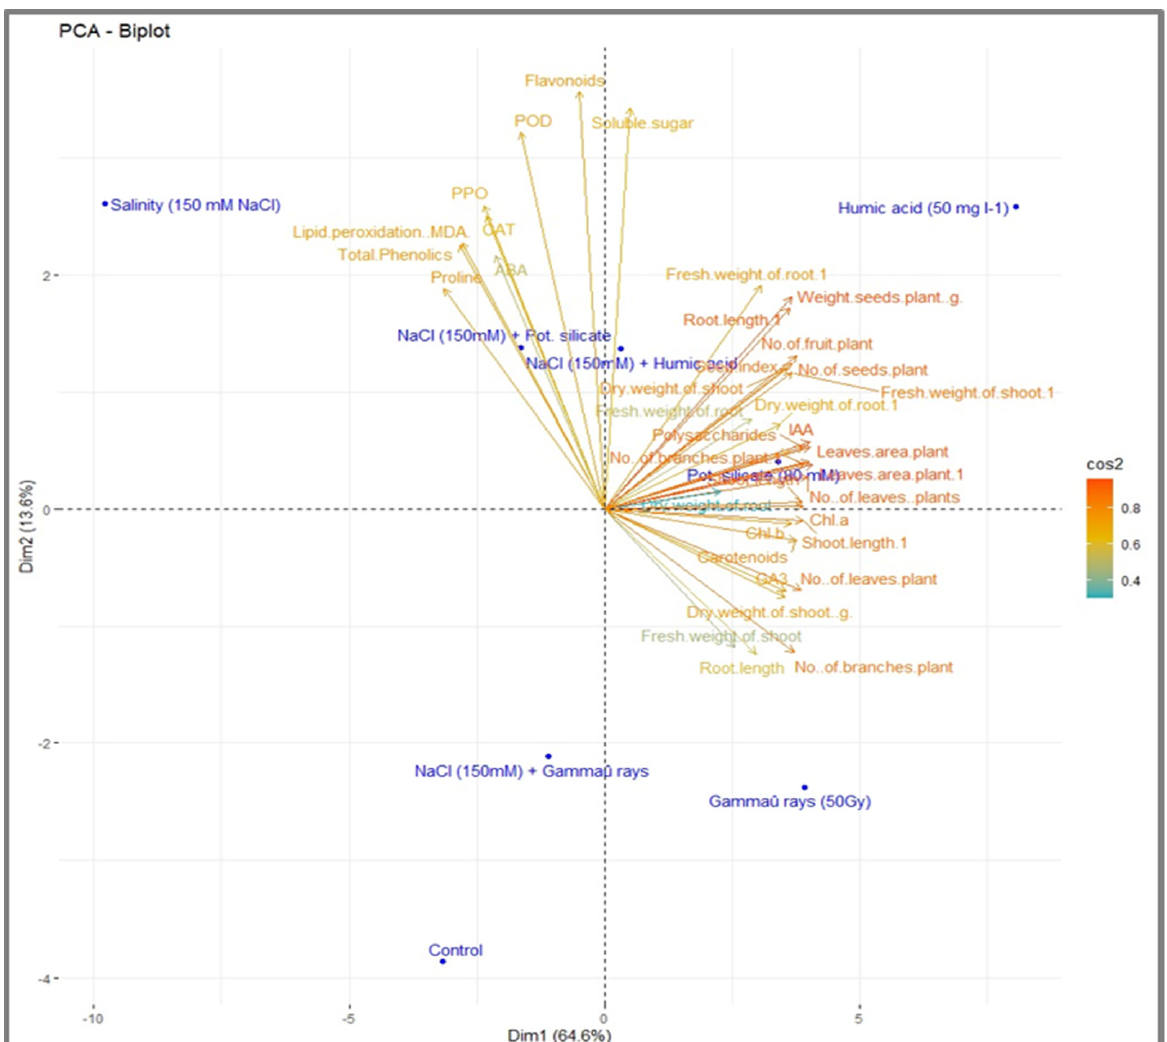
Figure 2. PCA biplot was conducted by blotting the first two principal components, illustrating the plotting of the studied morphological and metabolic measurements using multivariate analysis in R software.